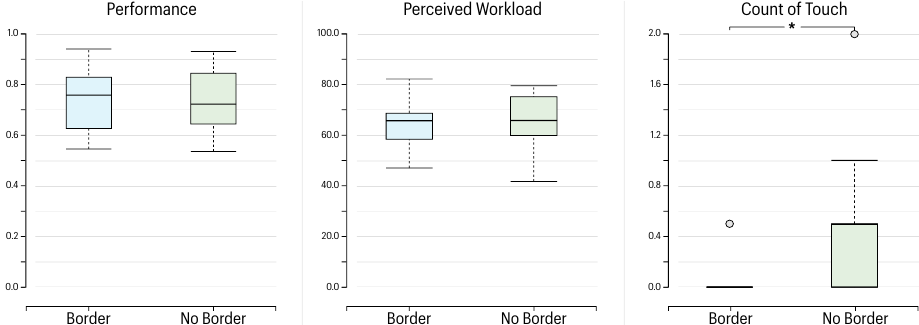
Figure 5. Results on performance ( left ), perceived workload ( middle ), and count of touching the car interior ( right ) for the No Border and Border conditions. The perceived levels of workload were moderate to high along with comparable performance across conditions. Despite the low amount of touching with regards to the car interior in both conditions, participants touched the car interior significantly less when seeing virtual borders in the Border condition. * indicates significant difference between two conditions with p ≤